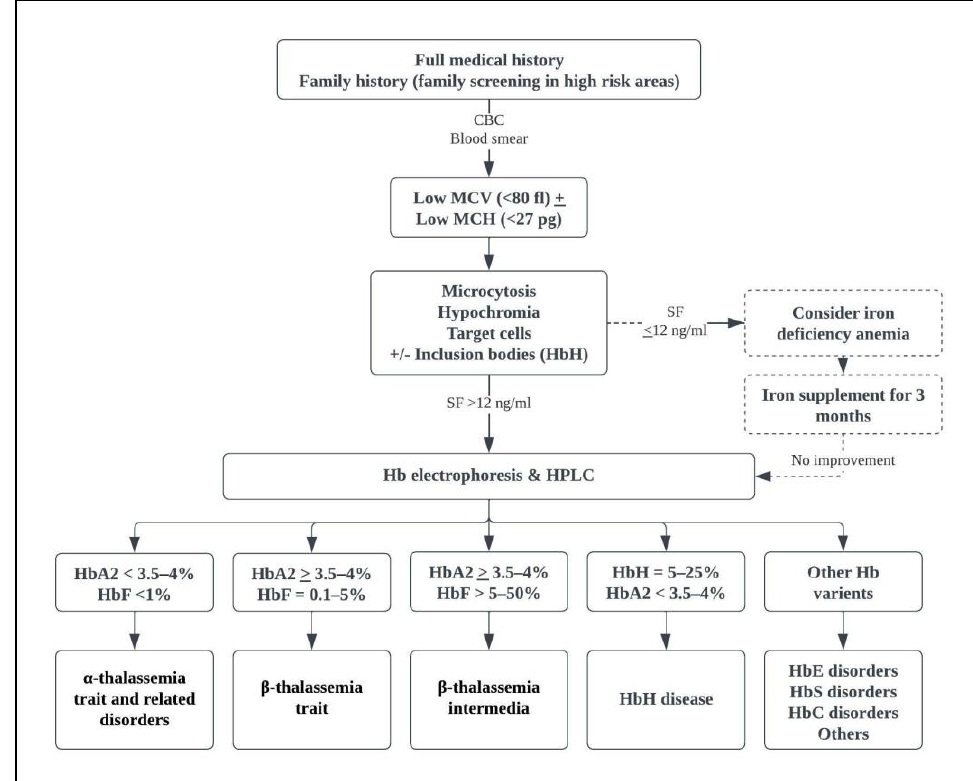
Figure 2. Diagnostic algorithm for lab diagnosis of NTDT.[30] CBC: complete blood count; Hb: he- moglobin; HPLC: high performance liquid chromatography; MCH: mean corpuscular hemoglobin; MCV: mean corpuscular hemoglobin; NTDT: non-transfusion dependent thalassemia; SF: serum ferritin.